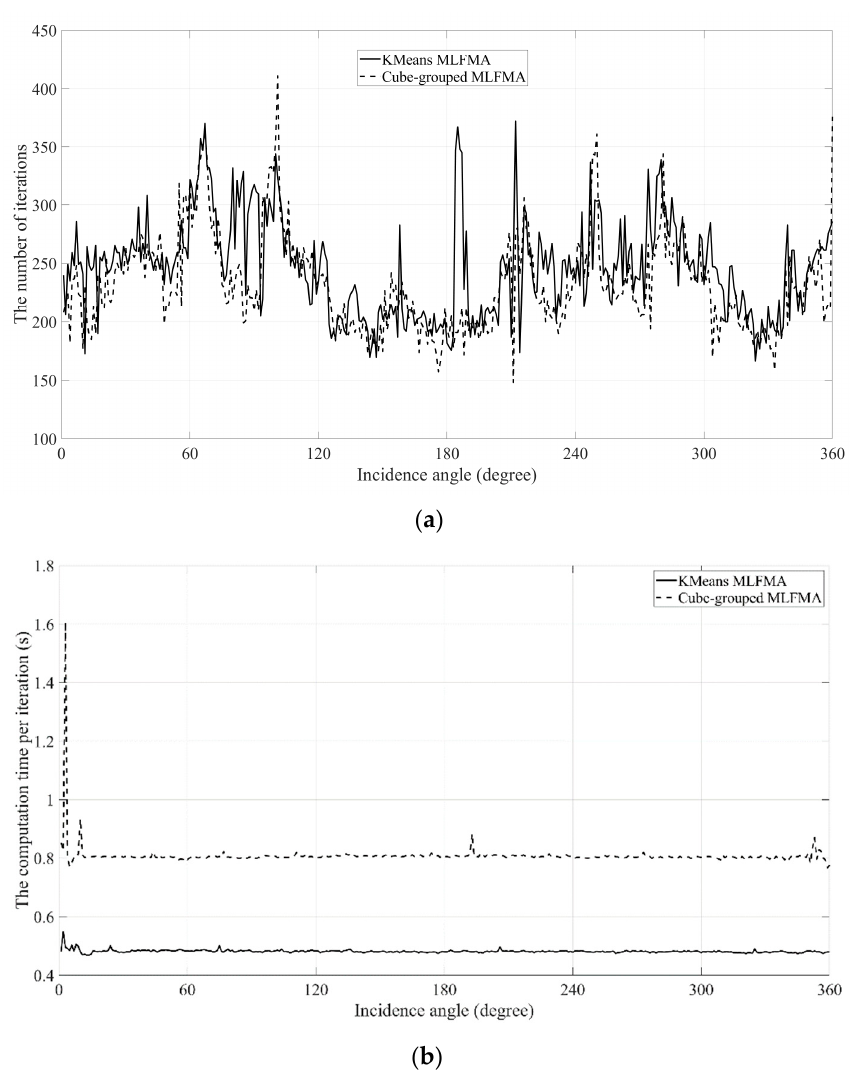
Figure 16. F16 aircraft CAD model simulation results: ( a ) the number of iterations as a function of the